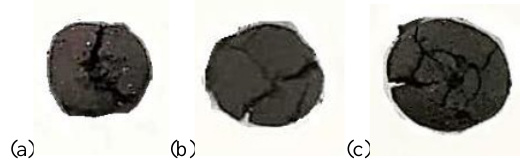
Fig. 7. Compressive crushing modes of LWCA particles in experiments: (a). two-part fracture, (b). three-part fracture, (c). four-part fracture.